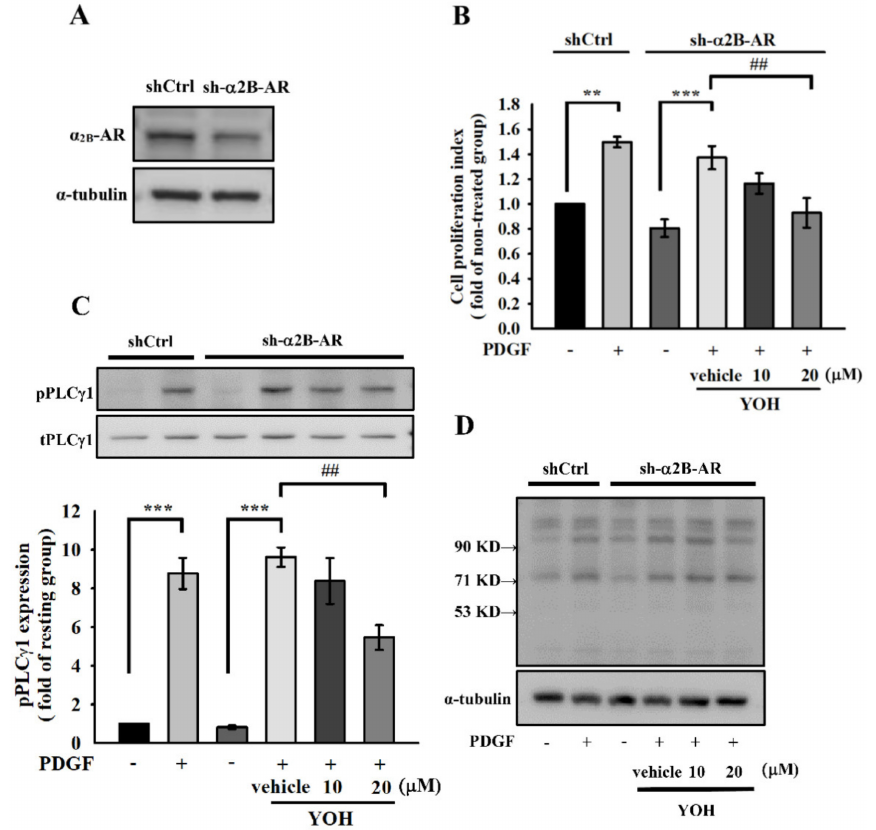
Figure 5. Effects of YOH on PDGF − BB-induced cell proliferation and PLC γ 1 phosphorylation in MOVAS − 1 cells with α 2B − adrenergic receptor knockdown. We performed α 2B − adrenergic receptor knockdown by incubating the cells with lentiviral particles of α 2B − adrenergic receptor shRNA for 24 h and then culturing them with selection medium. ( A ) Expression of α 2B − adrenergic receptors in wild − type cells and MOVAS − 1 cells with α 2B − adrenergic receptor knockdown. ( B ) Cell proliferation index was measured using the MTT assay, and protein expression lev- els of phospho − PLC γ 1 ( C ) and phospho − (Ser) PKC substrates ( D ) were recognized by anti- phospho − PLC γ 1 or anti − phospho − (Ser) PKC substrate antibodies, respectively, and then de- termined through Western blotting. ** p < 0.01, *** p < 0.001 compared with the non − PDGF-treated group; ## p < 0.01 compared with the positive control group. Data are presented as ± S.E.M. ( n =